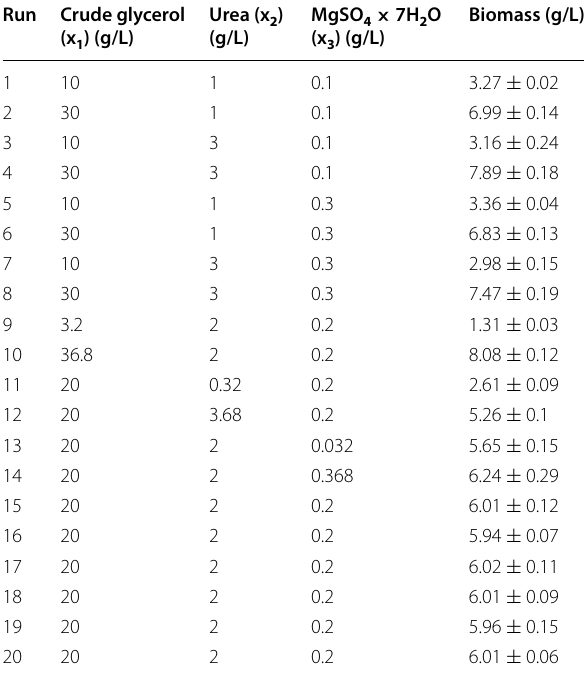
Table 2 Central composite design matrix of the independ- ent variables with the corresponding experimental values of biomass concentration Run Crude glycerol (x 1 ) (g/L)